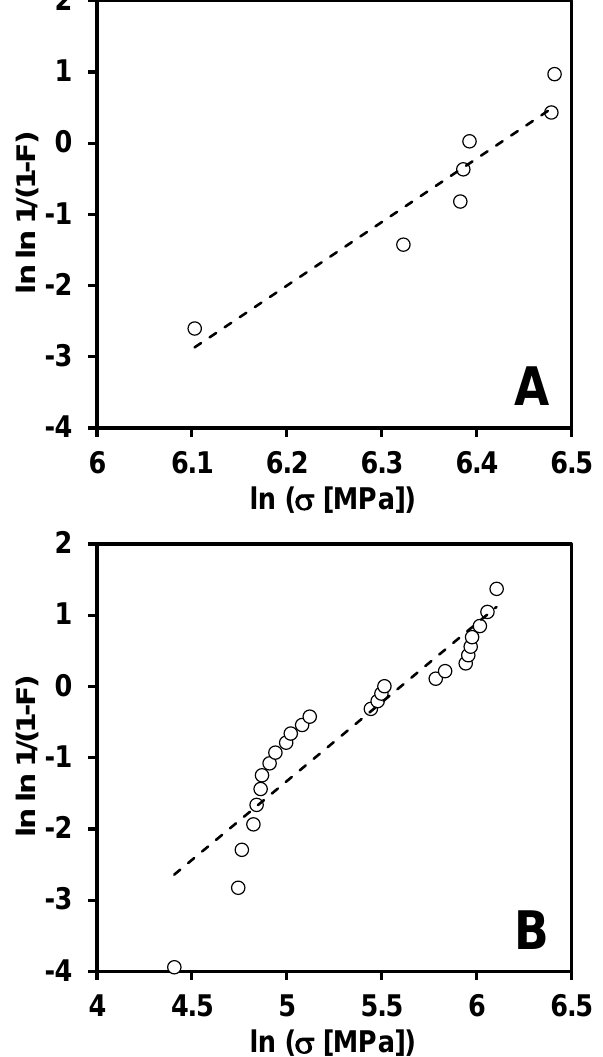
Figure 10. TheWeibullprobabilityplotsof( A )4-pointflexurestrengthand( B Figure 10. The Weibull probability plots of ( A ) 4-point flexure strength and ( B ) ring-on-ring biaxial strength.